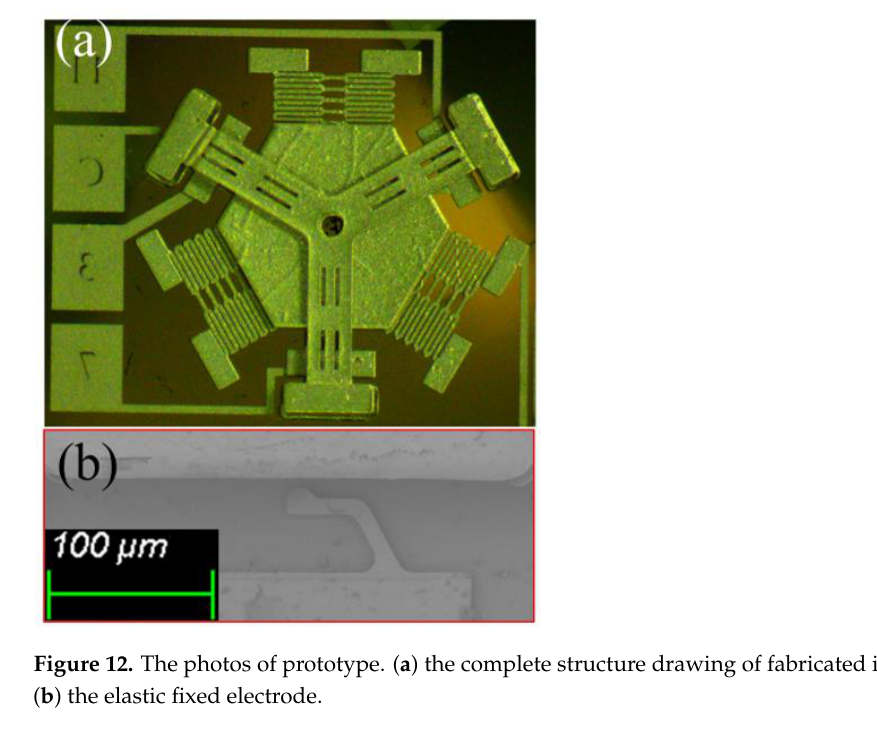
Figure 11. The diagram of fabrication process. ( a ) pad layer, ( b ) supporting layer, ( c ) spring layer,